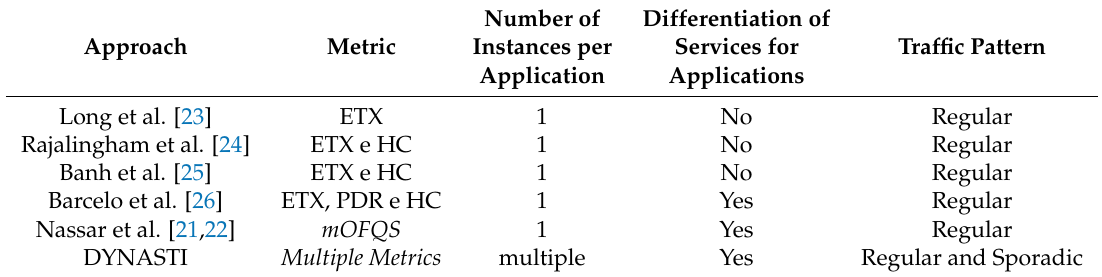
Table 1. Comparison between the related work against our